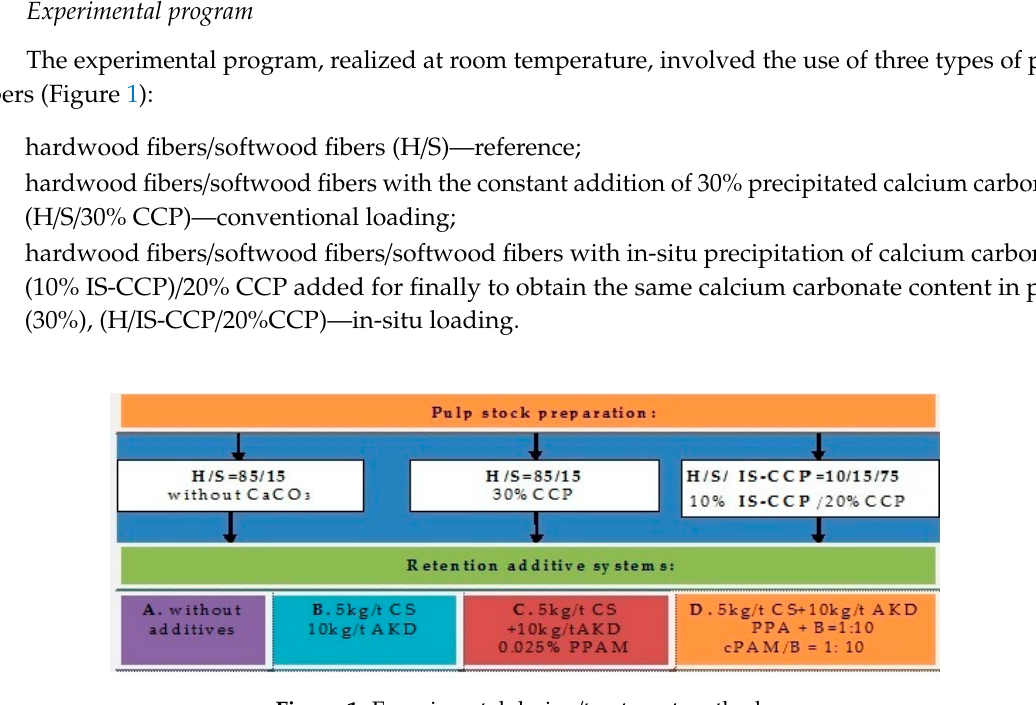
Figure 1. Experimental design/treatment methods.